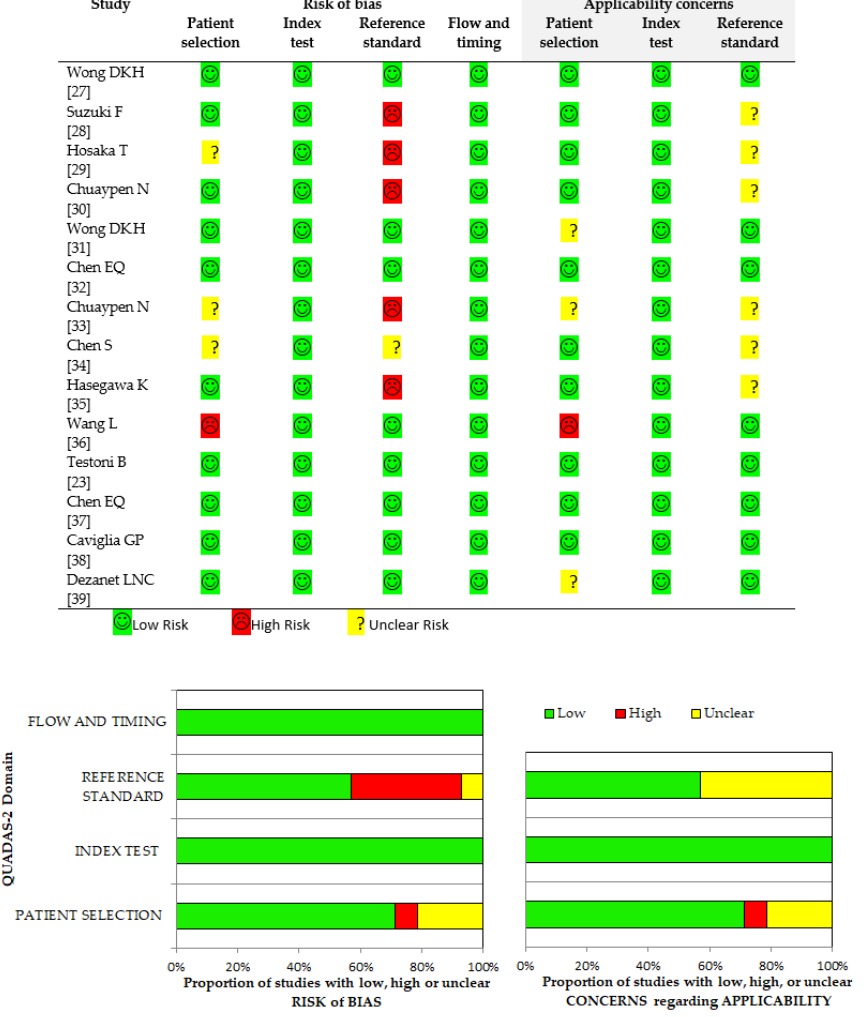
Figure 2. Overall methodology quality assessment of included studies using QUADAS-2 criteria. Abbreviations: Quality Assessment of Diagnostic Accuracy Studies version 2 (QUADAS-2).